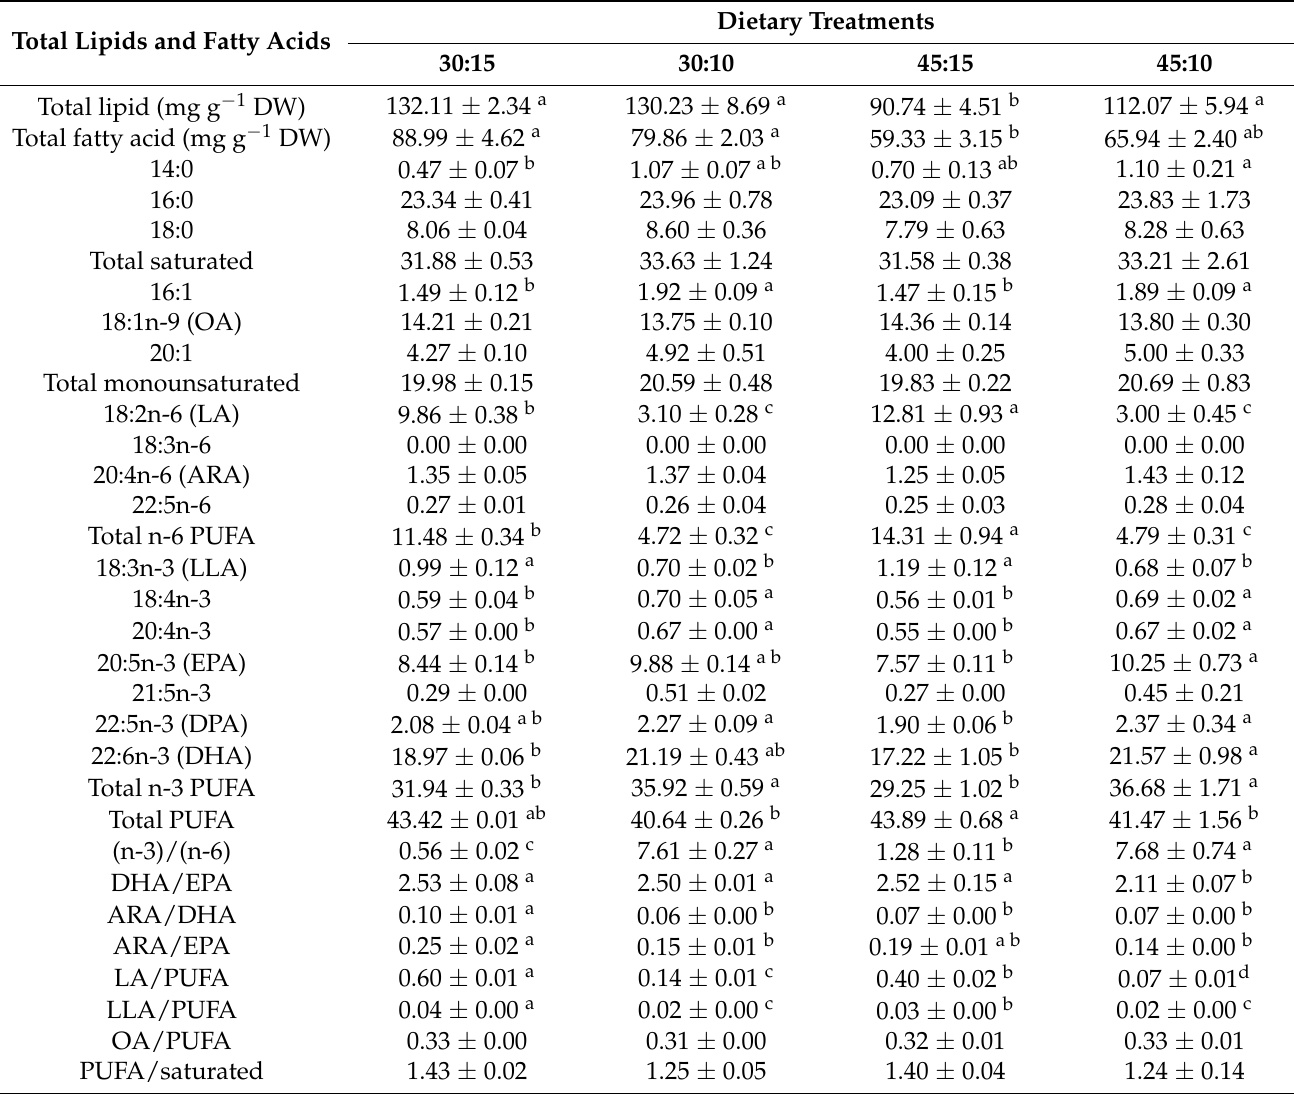
Table 6. Total lipid and total fatty acids contents (in % of dry matter) and fatty acid composition (in % TFA) analyzed in P. punctifer individuals of 26 dpf. Data are expressed as mean ± S.D. ( n = 3). Different superscript letters denote differences statistically significant between dietary treatments (one-way ANOVA, p < 0.05). Dietary treatment codes correspond to the protein:lipid level included in the tested diets. TFA, total fatty